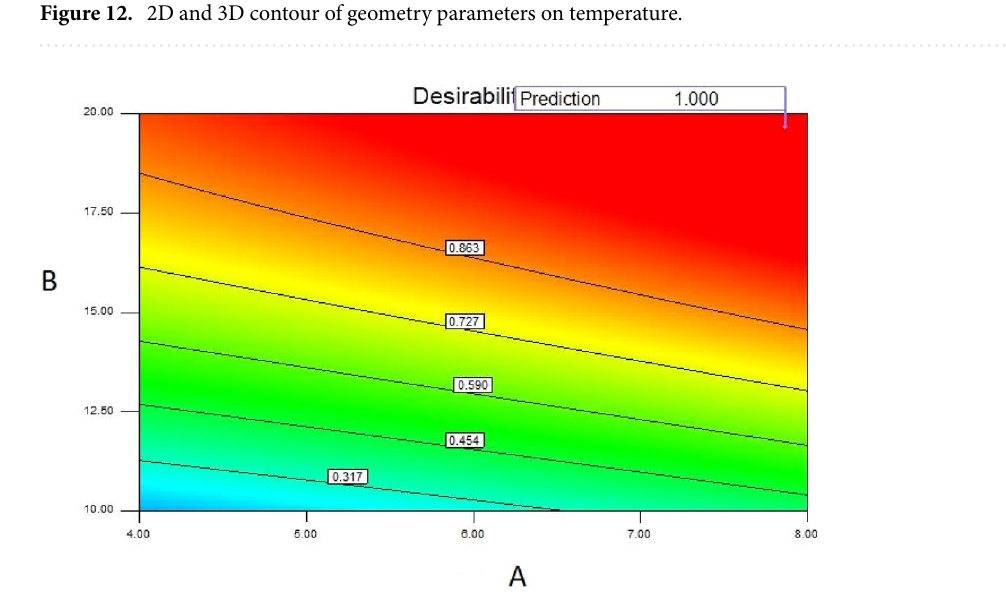
Figure 12. 2D and 3D contour of geometry parameters on temperature.